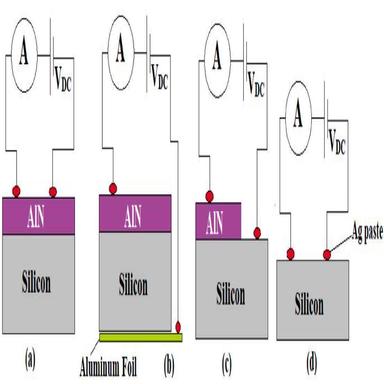
Physical schemes for electrical characterizations. (a) Top Surface, (b) Top Bottom, (c) Etched Surface and (d) Backside Silicon.